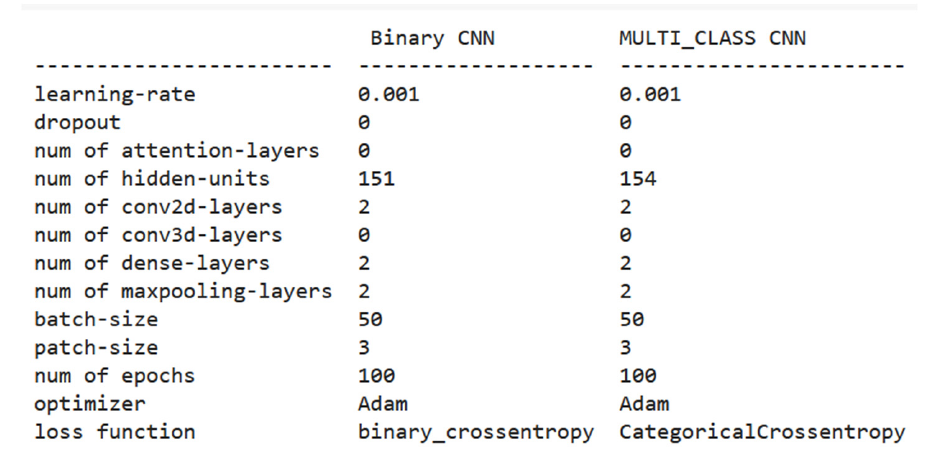
Figure 8. Summary of the used hyperparameters for our